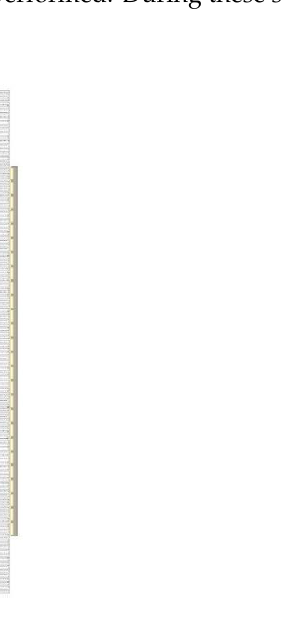
Figure 5. The model presents a translator shorter than the stator, i.e., the longitudinal ends is